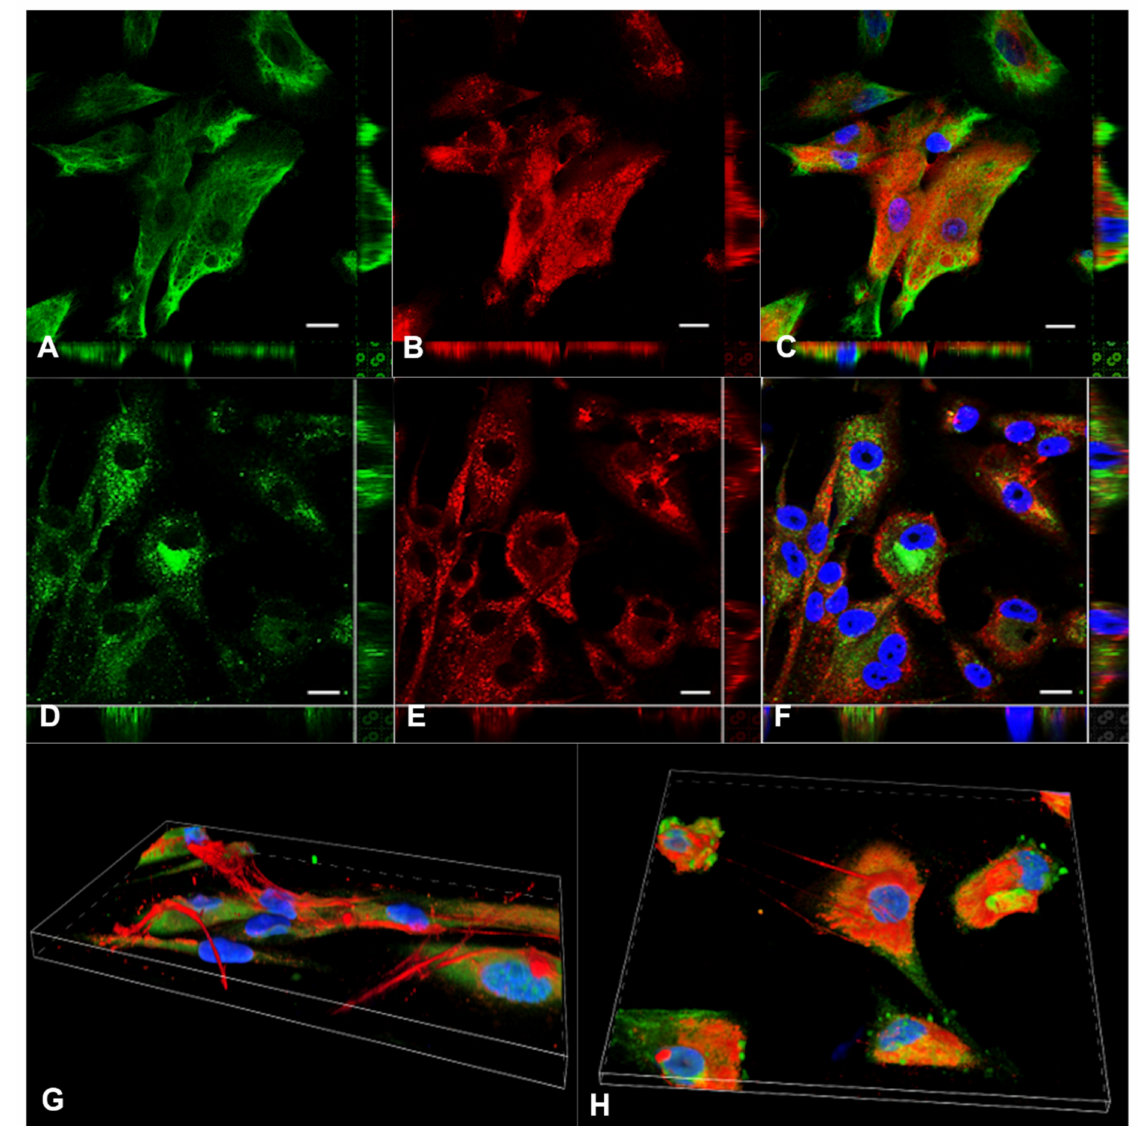
Figure 3. ( A – C ) HA synthesis by primary MPM cells and its intracellular distribution. MPM primary cells were fixed, permeabilized and co-stained for vimentin ( A ) in order to visualize cell morphology; and for HA binding protein (HABP) ( B ) in order to detect HA presence inside the cells. Intense HA staining inside the cytoplasm of MPM primary cells was clearly detected and illustrated by the reported z-projections. The merge ( C ) allowed the visualization of intracellular HA staining as vesicular or globular structures prominently concentrated in the perinuclear region of cells. Nuclei were stained in blue. The presence of an HA pericellular coat could not be detected because of the use of fixatives. Scale bar: 10 µ m. ( D–F ) Endocytosis of exogenous HA by MPM primary cells. Fluorescein-labeled (HA-Fl) (10 µ g/mL) was supplied to MPM primary cells in the culture to be taken up during overnight (ON) incubation ( D ). Cells were then fixed and stained with HABP for endogenous intracellular HA detection ( E ). The two pools do not overlap ( F ). Nuclei were stained in blue. Scale bar: 10 µ m. ( G , H ) 3D reconstruction of the distribution of HA produced by MPM primary cells. Detection of HA cables, protrusions that connect adjacent cells, was observed in particular in the perinuclear